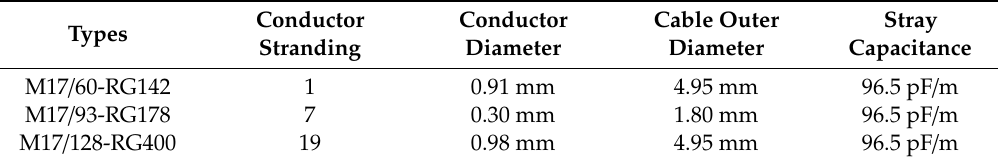
Table 2. The types and main characters of three coaxial